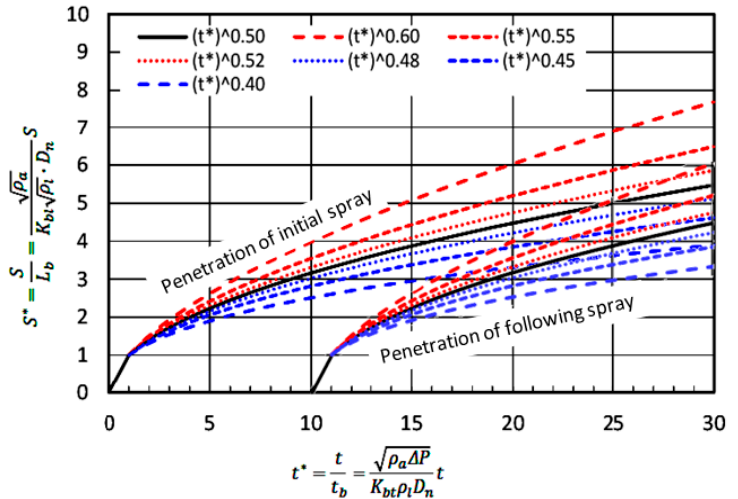
Figure 13. Penetrations of initial and following sprays. Delayed starting time of the following spray is 10 on non-dimensional timescale. is 10 on non-dimensional